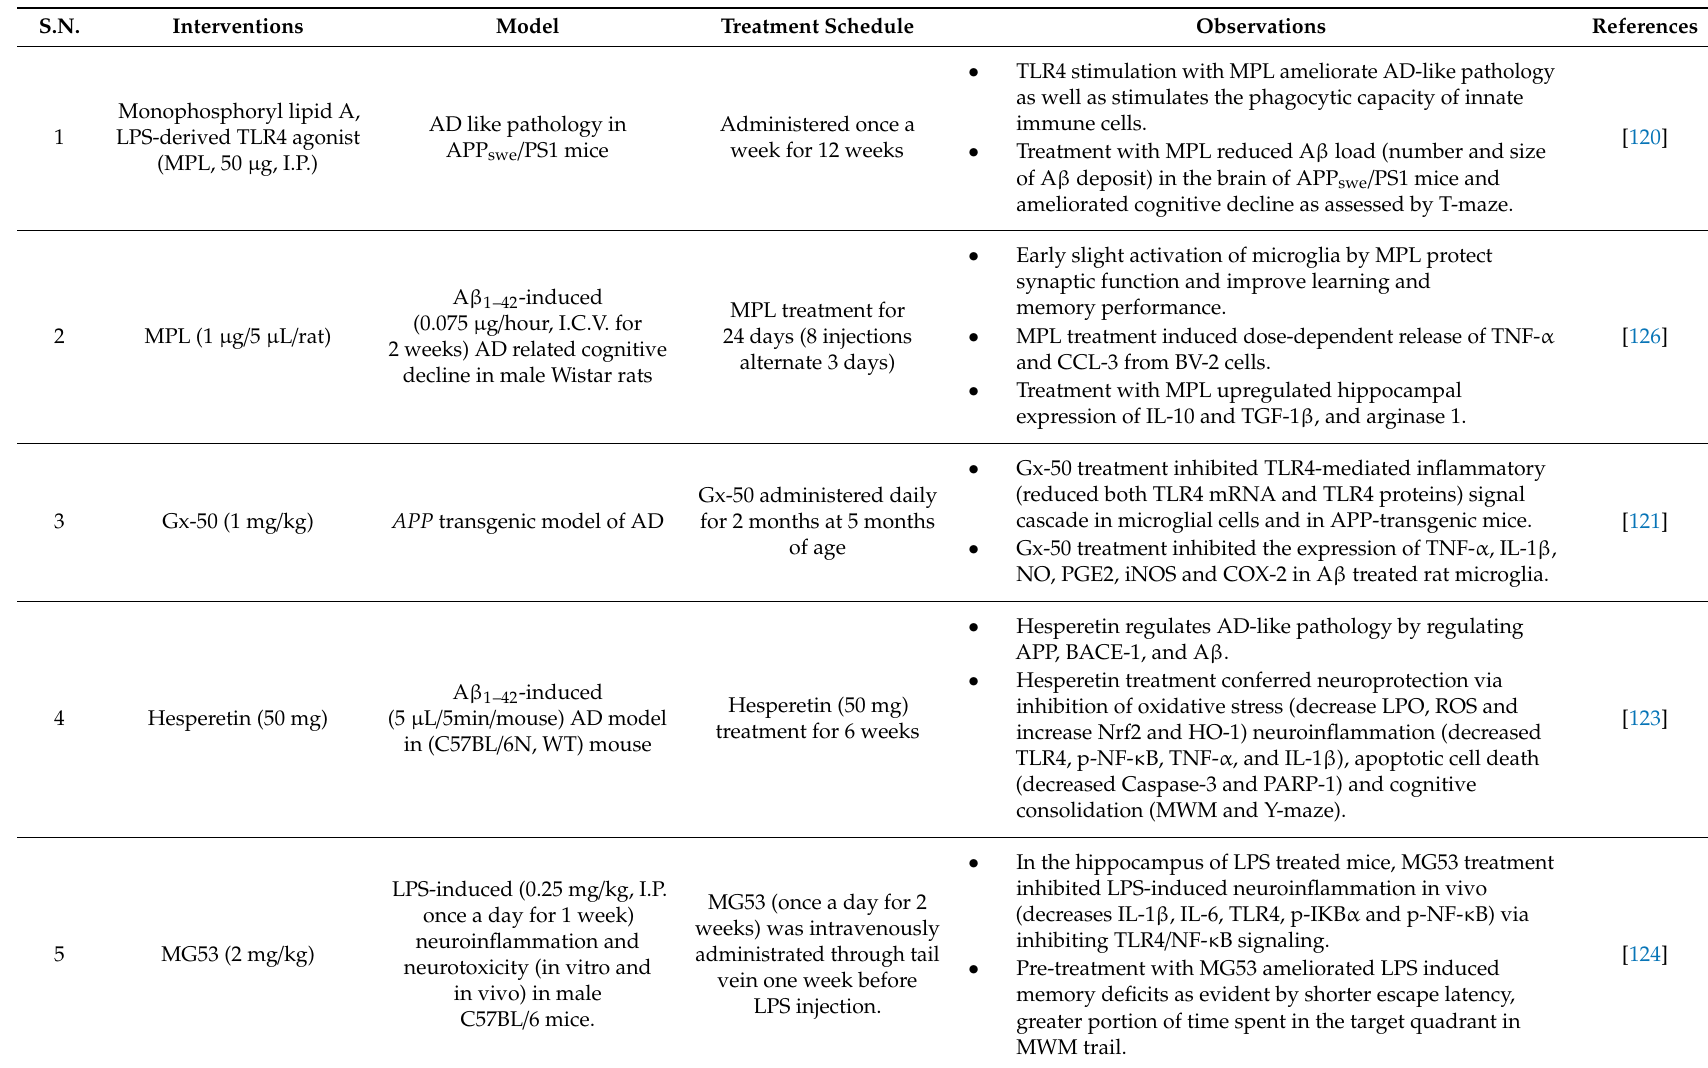
Table 3. Summaries of pre-clinical studies investigating TLR4 inhibition in AD-like pathology.